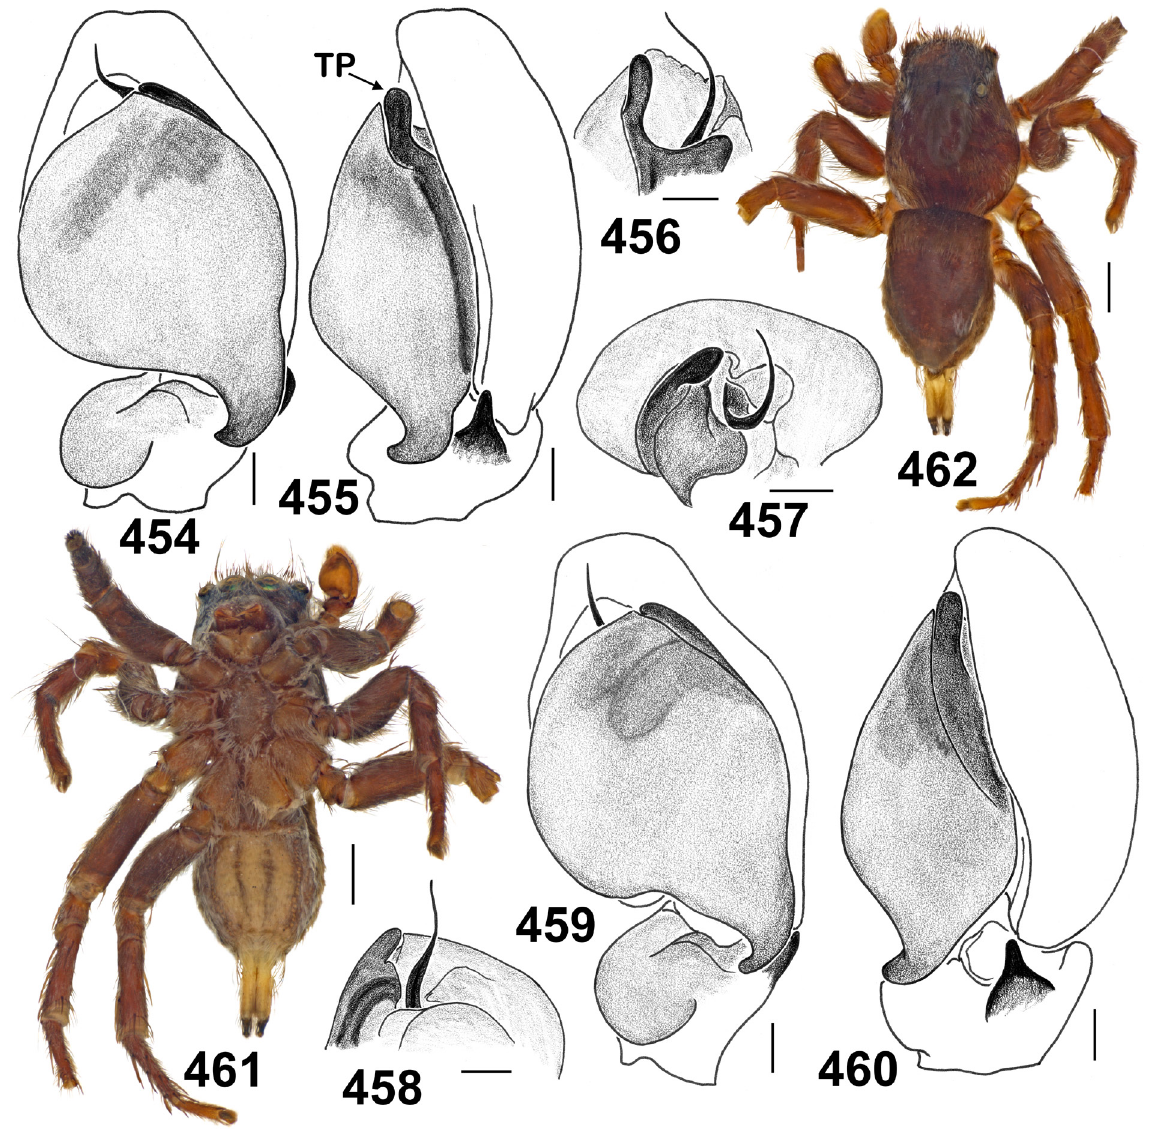
Figs 454–462. Stenaelurillus strandi Caporiacco, 1939 , holotype, ♂ (459–462) and paratype (454–458) . 454 , 459 . Male palp, ventral view. 455 , 460 . Male palp, retrolateral view. 456–458 . Embolic division. 456 . Retrolateral view. 457 . Apical view. 458 . Median view. 461–462 . General appearance. Scale bars: 454–460 = 0.1 mm; 461–462 = 1